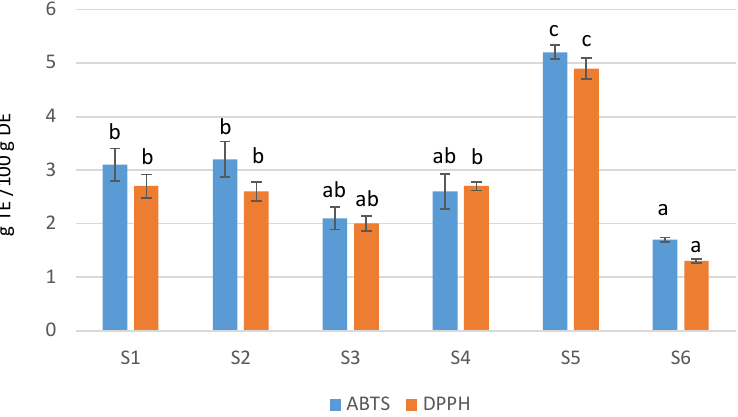
Figure 2. Antioxidant assays (g TE/100 g DE) for the analyzed M. oleifera food supplements. Means of the same assay not sharing the same letter are significantly different at p < 0.05 probability level.